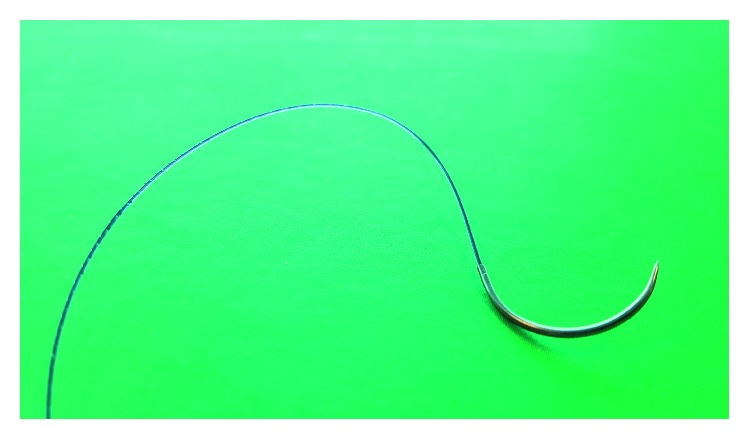
V-Loc barbed suture.